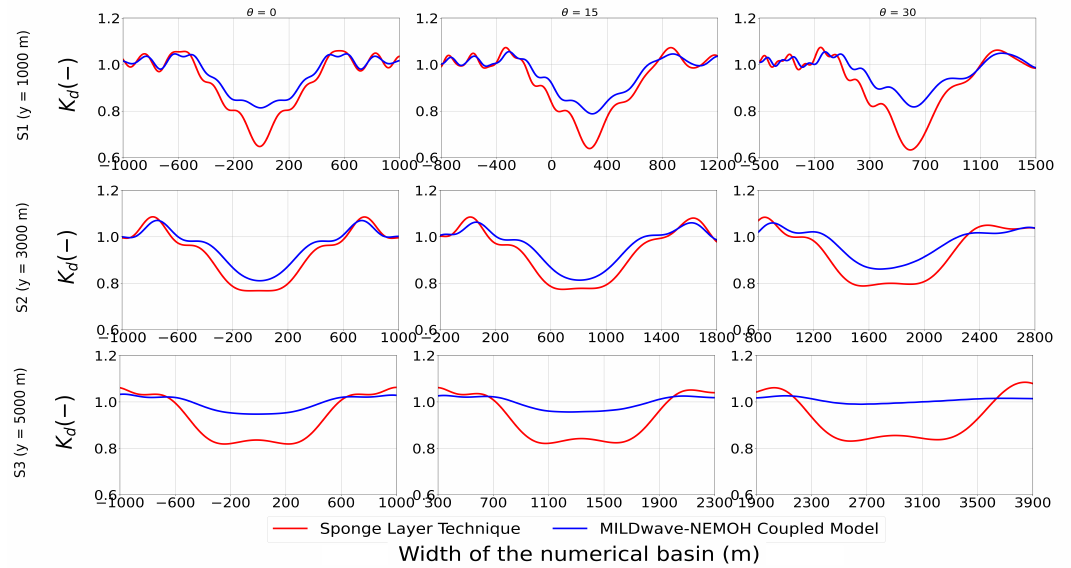
Figure 7. K d disturbance coefficient results along three transversal cross-sections S1, S2 and S3 as indicated in Figures 6, for a 21 HPA farm interacting with regular waves of H = 2.0 m and T = 8 s and θ = 0 ◦ , 15 ◦ and 30 ◦ ,